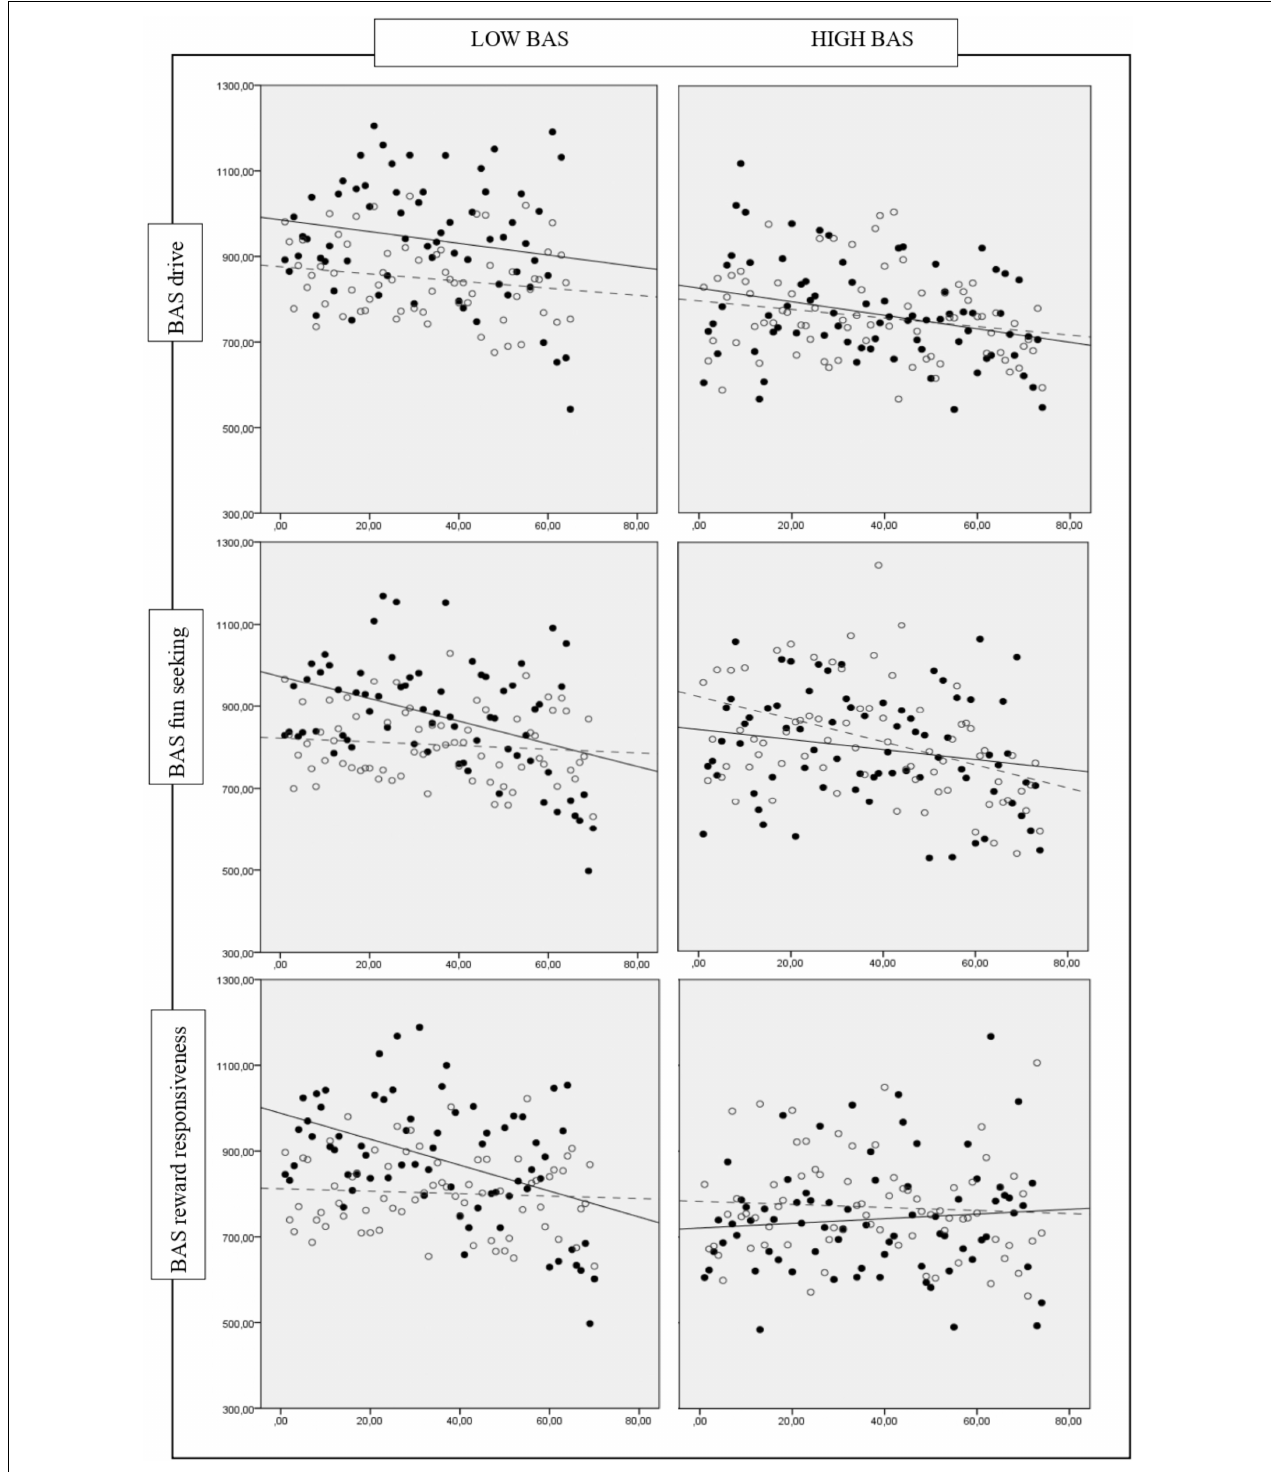
FIGURE 1 | Comparison between the average RT of individuals that perform Hypoxia (black dots and solid line) and Normoxia condition (gray dots and dashed line) across low vs. high BAS groups (drive, fun seeking or reward responsiveness) in the BST Mixed condition. Black dots and solid line, average RT per trials of individuals that perform hypoxia condition; Solid line, trend of average RT on hypoxia condition; Gray dots and dashed line, average RT per trials of individuals that perform normoxia condition; Dashed line, trend of average RT on normoxia condition x, trials numbers; y, time reactions in milliseconds.